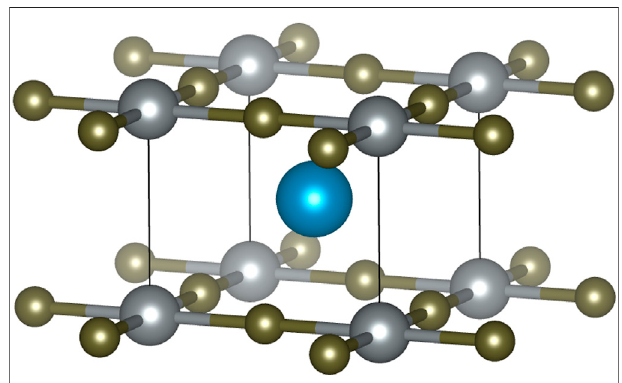
FIGURE 1 | Crystal structure of YNiO 2